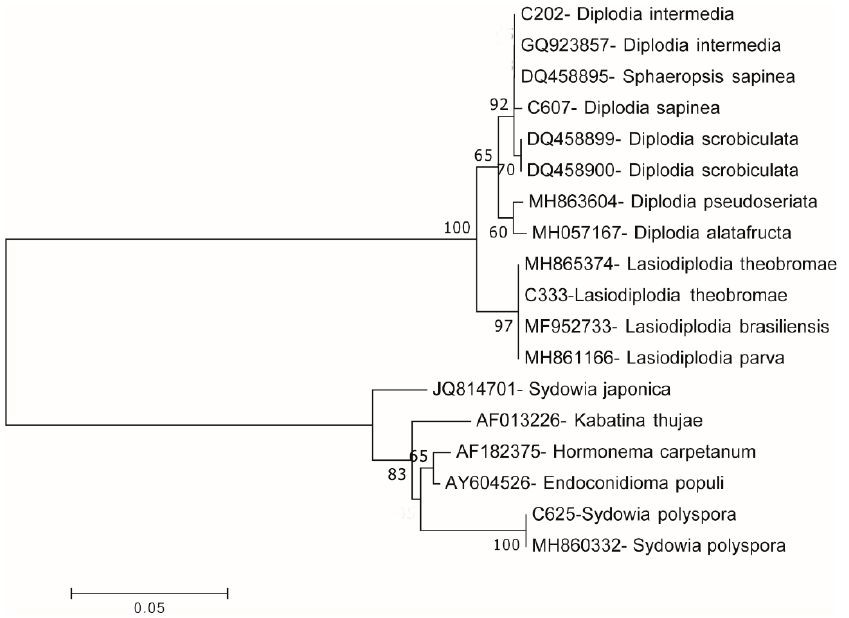
Figure 6. Neighbour joining phylogenetic tree based on the ITS region showing the position of SpOTUs C202, C607, C333 and C625 in relation to other taxa. Bootstrap support values (percentages of 1000 replicates) are shown on branches (values, 50 % are not shown).